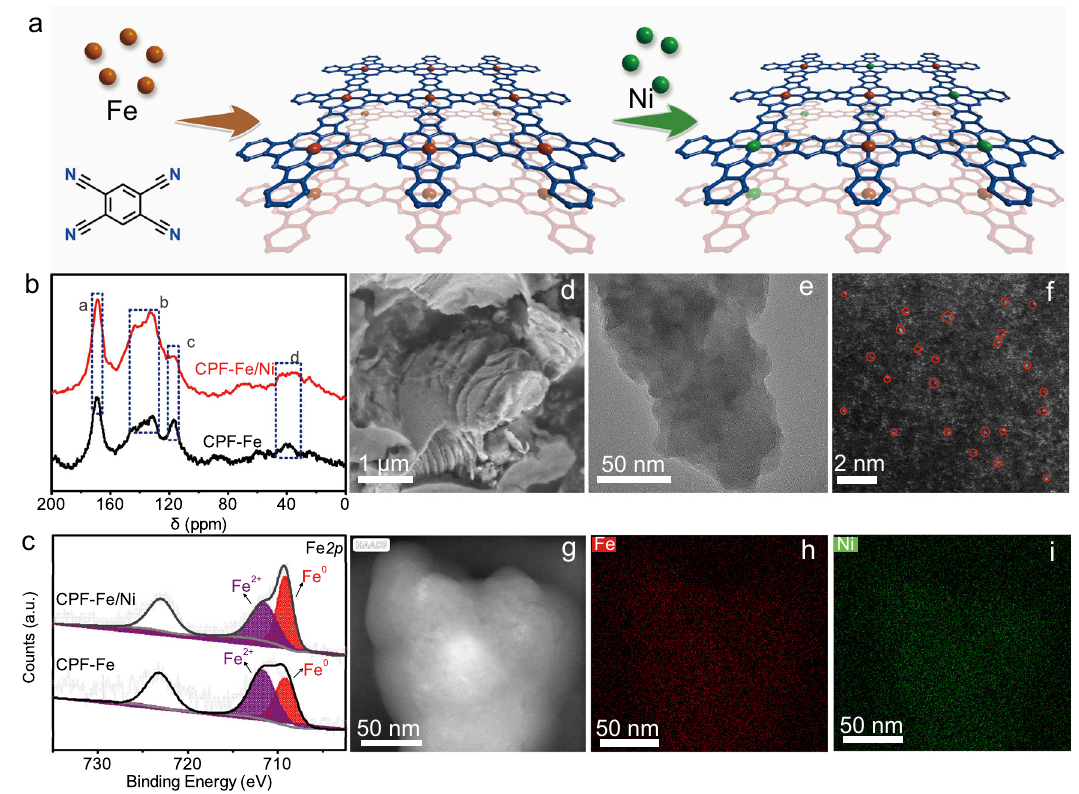
Fig. 1 | Schematic illustration and structural characterization of CPF-Fe/Ni. a ThesynthesisprocessofCPF-Fe/Ni, b Solid-stateCP-MAS 13 C-NMRspectraofCPF- FeandCPF-Fe/Ni, c High-resolutionFe2pspectraofCPF-FeandCPF-Fe/Ni,theblack